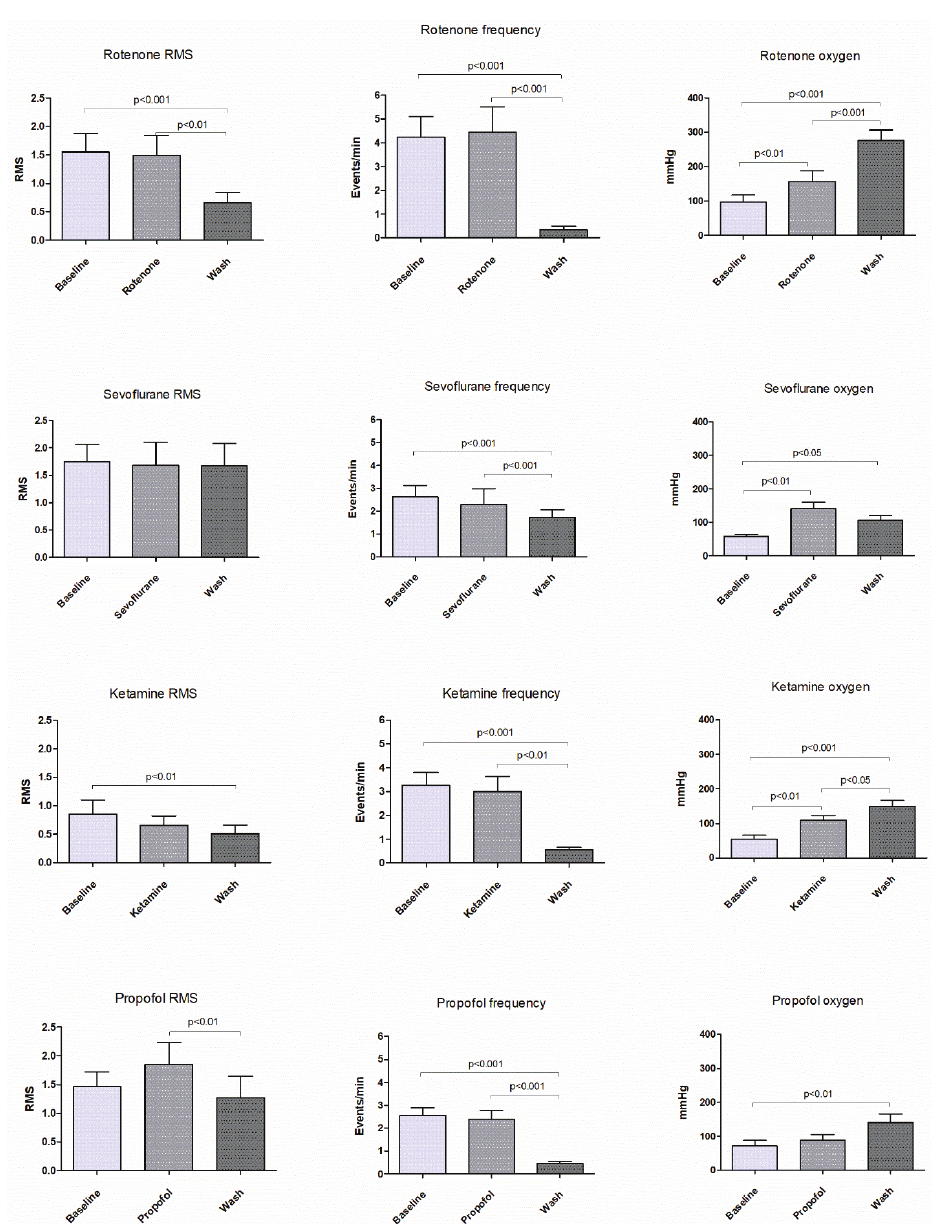
Figure 2. Graphs illustrating the effects on root-mean-square (RMS) seizure-like event (SLE) activity (left column), SLE frequency (middle column) and tissue oxygen (right column) of rotenone (1.5 μ M), sevoflurane (1 MAC), ketamine (17 μ M) and propofol (56 μ M). Data are mean + SEM.